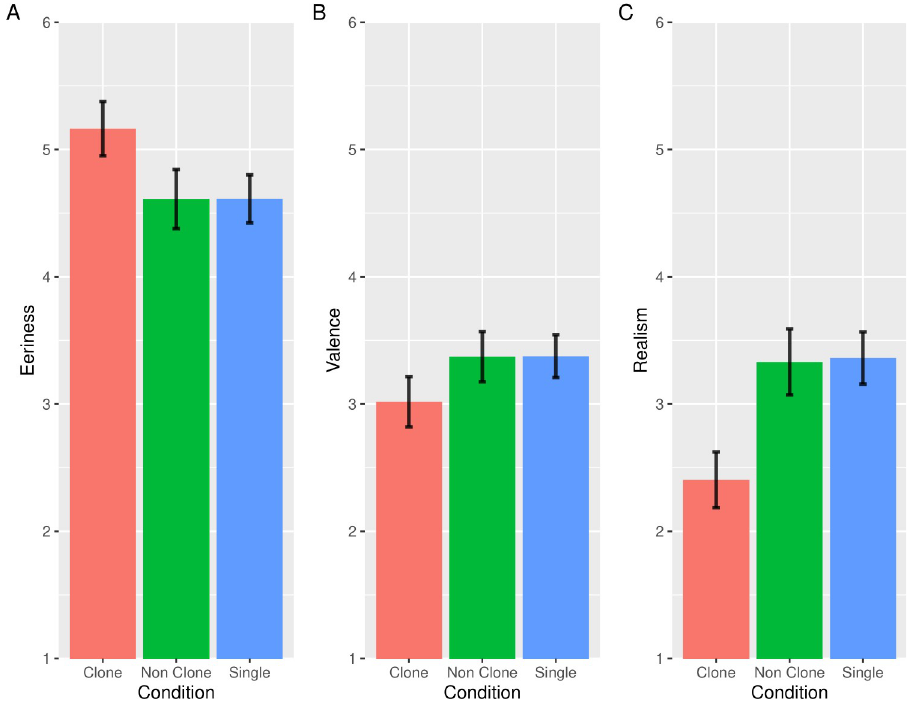
Fig 2. The results of the eeriness, valence, and realism evaluation in Study 1. Error bars indicate the standard errors of the mean. The vertical axes indicate the mean eeriness (A), valence (B), realism scores (C) for images in each condition. The lower scores indicate more negative and improbable